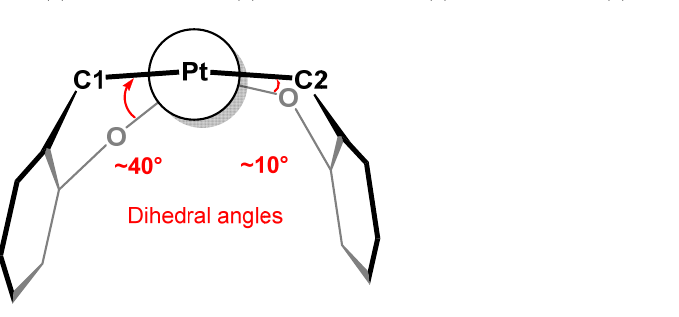
Figure 5. ORTEP view of the X-ray molecular structure of complex 3 · SMe 2 , with ellipsoids at the 50% probability level and H atoms omitted for clarity ( left ); schematic view of the B conformation adopted by the ligand PAr Xyl 2 (OPh NO 2 ,Me ) 2 ( right ) [17,25]. Selected bond distances (Å) and angles ( ◦ ): Pt1-P1 2.1526(9), Pt1-C1 2.155(3), Pt1-C2 2.120(3), Pt1-S1 2.339(1); P1-Pt1-C1 84.18(7); C1-Pt1-S1 86.74(8); S1-Pt1-C2 99.09(9); C2-Pt1-P1 89.23(8); C1-Pt1-C2 169(1).